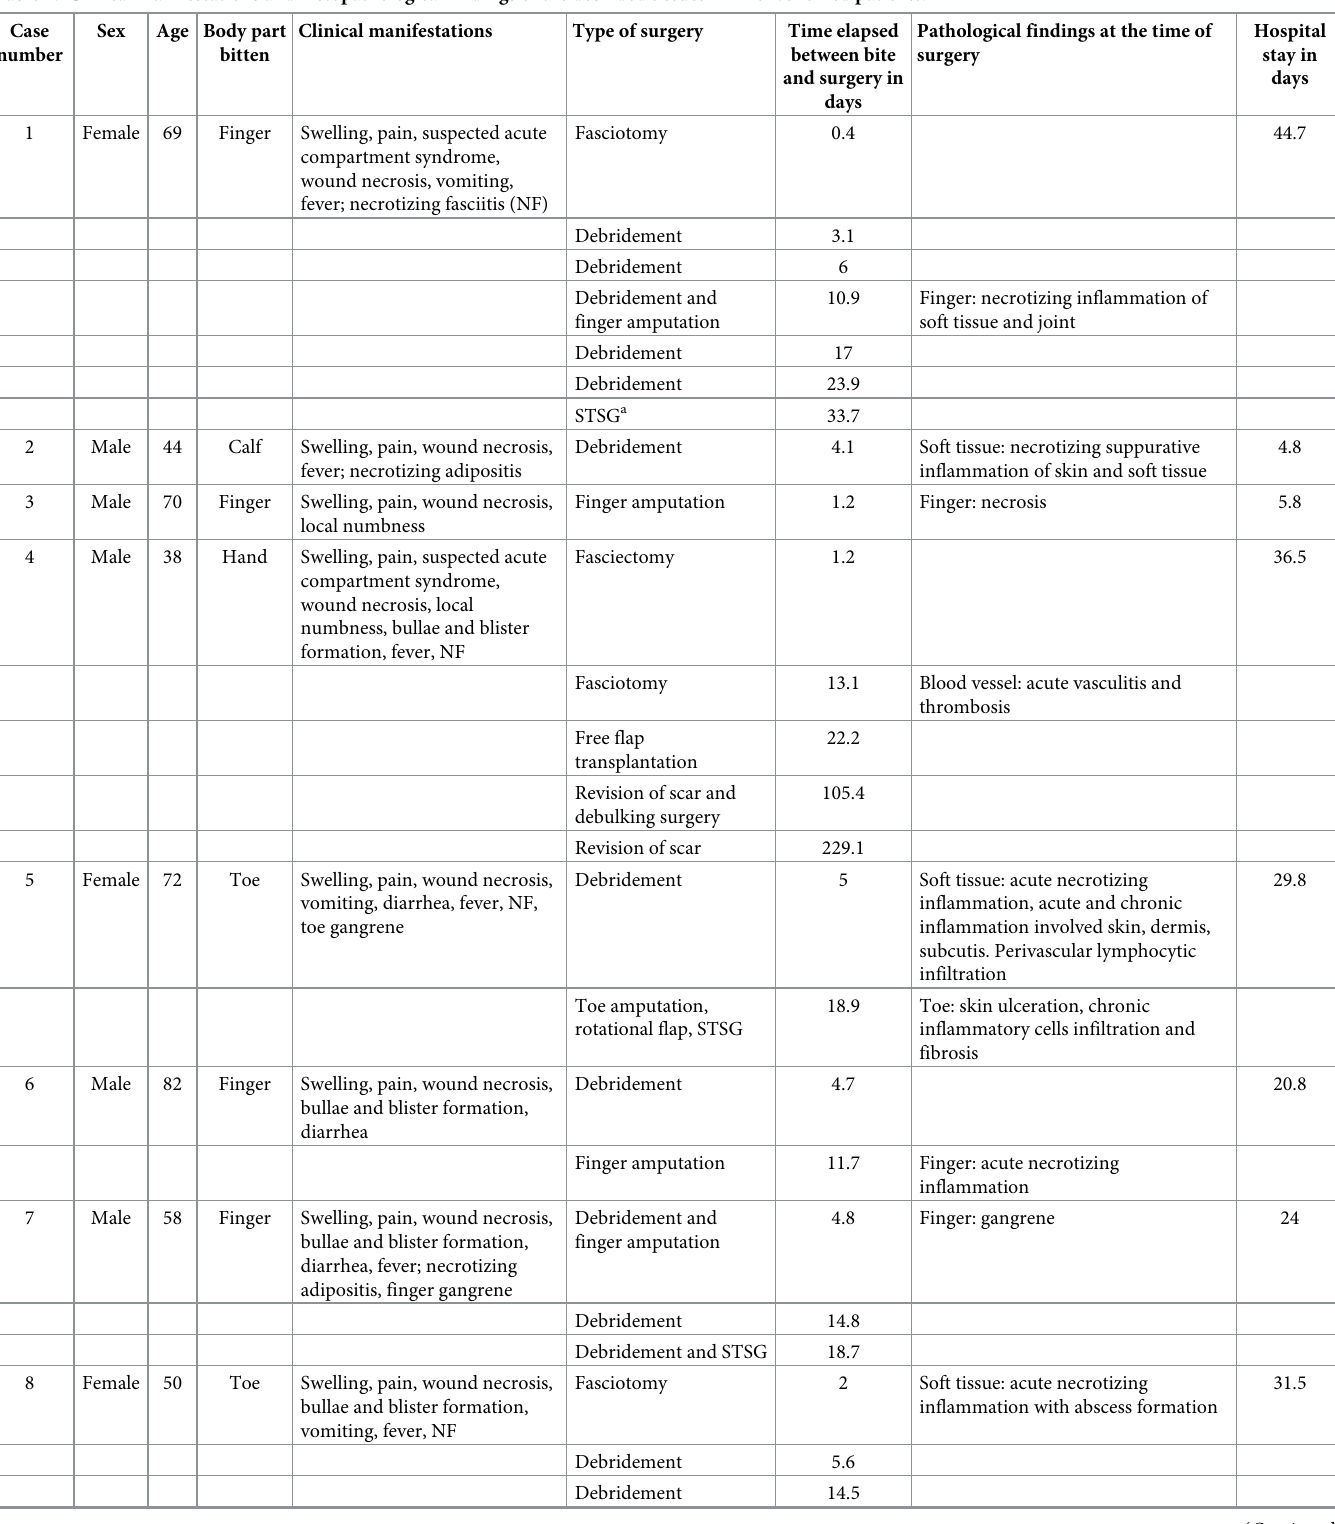
Table 4. Clinical manifestations and histopathological findings of the debrided tissues in 14 envenomed patients. Case